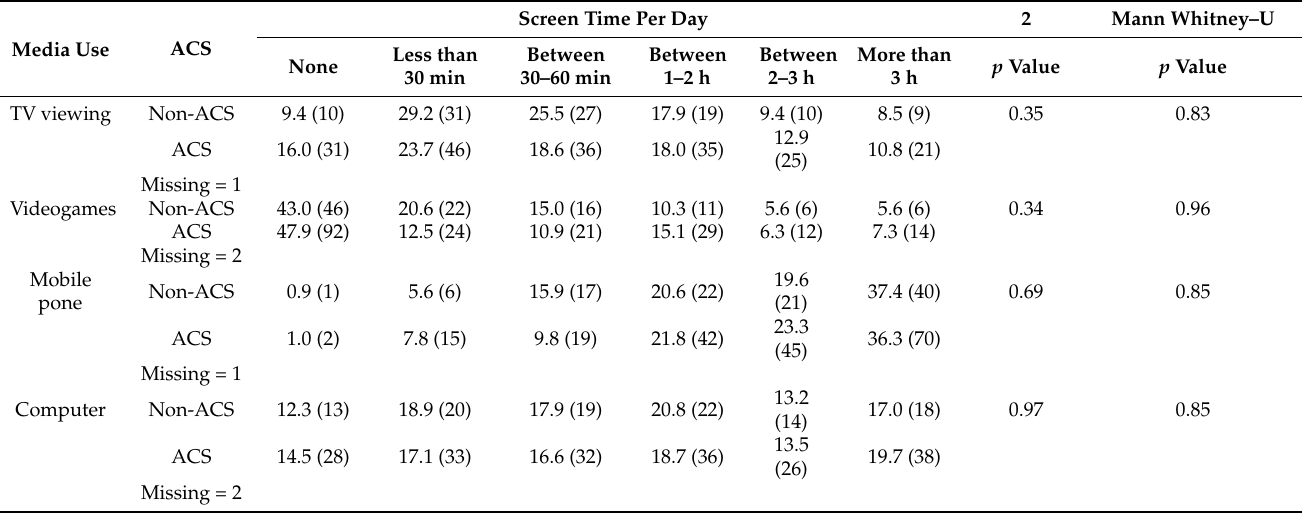
Table 2. Relationship between screen time and ACS.